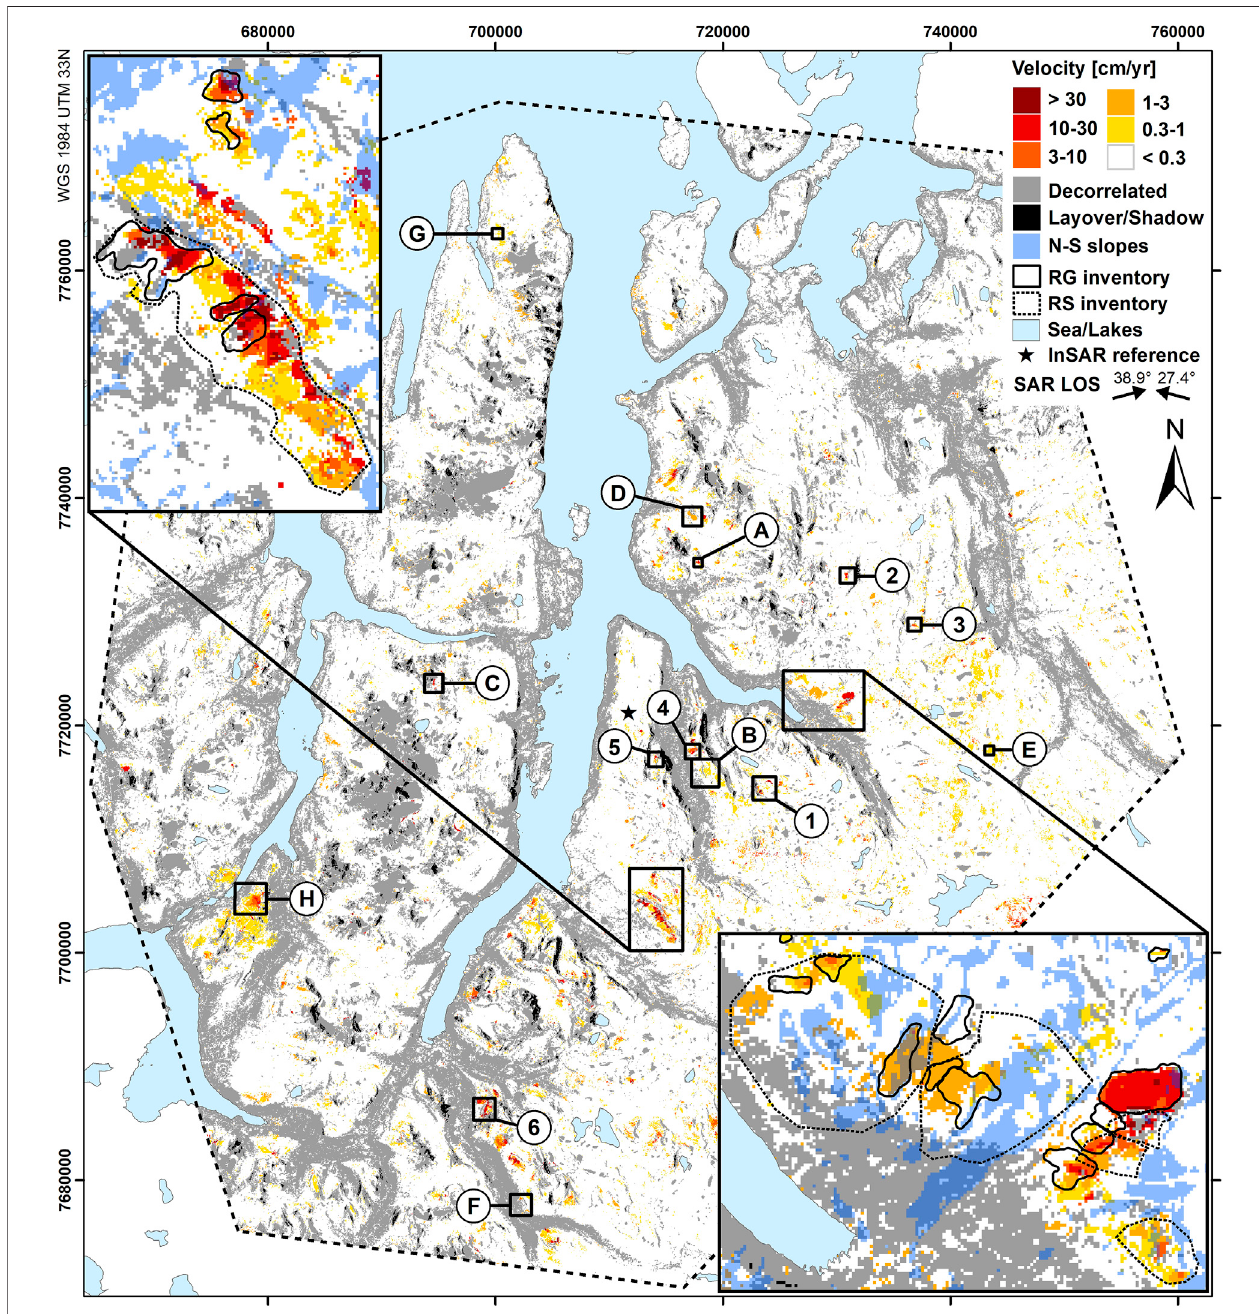
FIGURE 4 | Classi fi ed InSAR results and detailed views over Ádjet in Skibotndalen (upper-left) and Njárgavárri/Badjánvárri in Kåfjorddalen (lower-right) . Polygons in detailed maps: initial inventories of rock glaciers (RG, back solid lines) and rockslides (RS, black dashed lines). Note that the N – S slopes mask is here displayed only on the detailed maps for the sake of visualization. Locations (A – H) and (1 – 6) are the areas detailed in Figures 6 , 8 , 10 . Arrows in legend: line-of-sight (LOS) orientations. Sea and lakes from NMA (2020a).